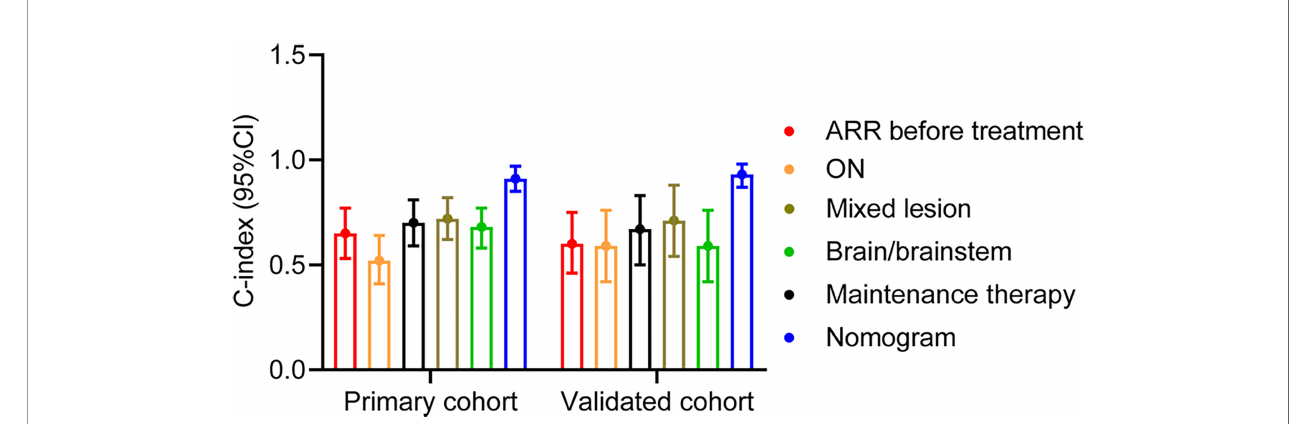
FIGURE 3 | Comparison of the C-indexes between nomogram and other risk factors. ARR, annual relapse rate.